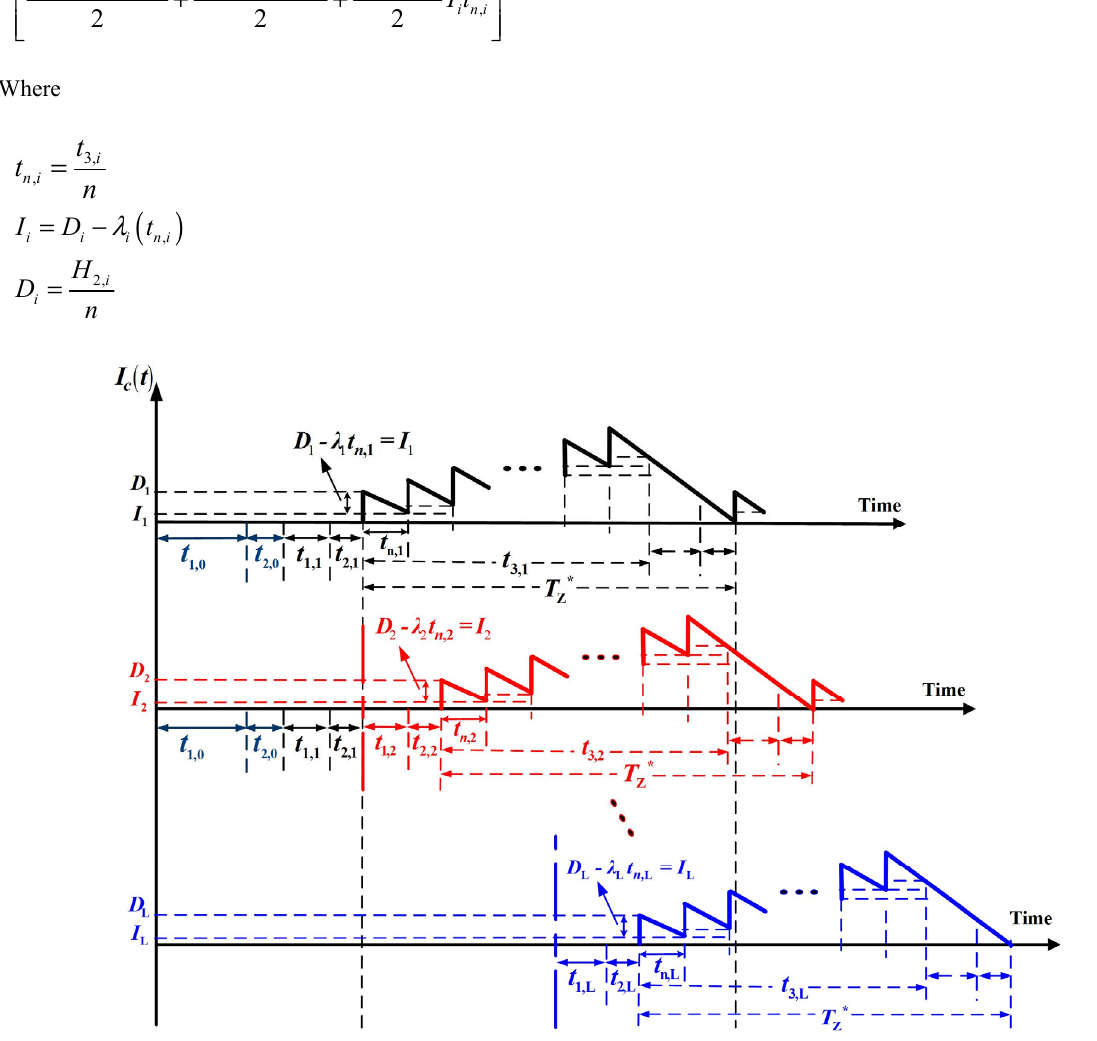
Fig. 5. End merchandise i ’s inventories status at client